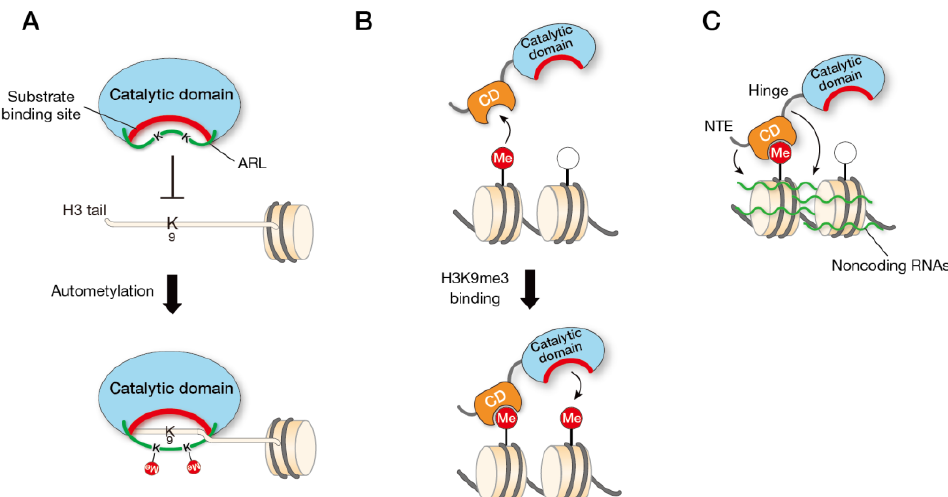
Figure 2. Regulatory mechanisms of Clr4/SUV39H HMTases. ( A ) Model for Clr4 autoregulation by automethylation of two lysines in Clr4. In the unmethylated state of lysines in the Clr4 autoregulatory loop (ARL), the ARL blocks the substrate binding and the methyltransferase activity of Clr4 is inhibited. Methylation of lysine residues within the ARL changes the conformation of the ARL, allowing the Clr4 catalytic domain to bind the H3 tail. ( B ) Model for a two-step activation of Clr4/SUV39H methyltransferase activity. In the absence of Clr4/SUV39H-CD binding to H3K9me, the methyltransferase activity is suppressed. When the CD of Clr4/SUV39H binds to the H3K9me of a nucleosome, the binding of Clr4/SUV39H to chromatin is stabilized, allowing methylation of H3K9 of adjacent nucleosomes. ( C ) Model for chromatin tethering of Clr4/SUV39H1 through RNA-binding activity. H3K9me3 modifications of histones and non-coding RNAs transcribed from pericentromeric repeats work together to promote the association of Clr4/SUV39H with heterochromatin. NTE, N-terminal extension.